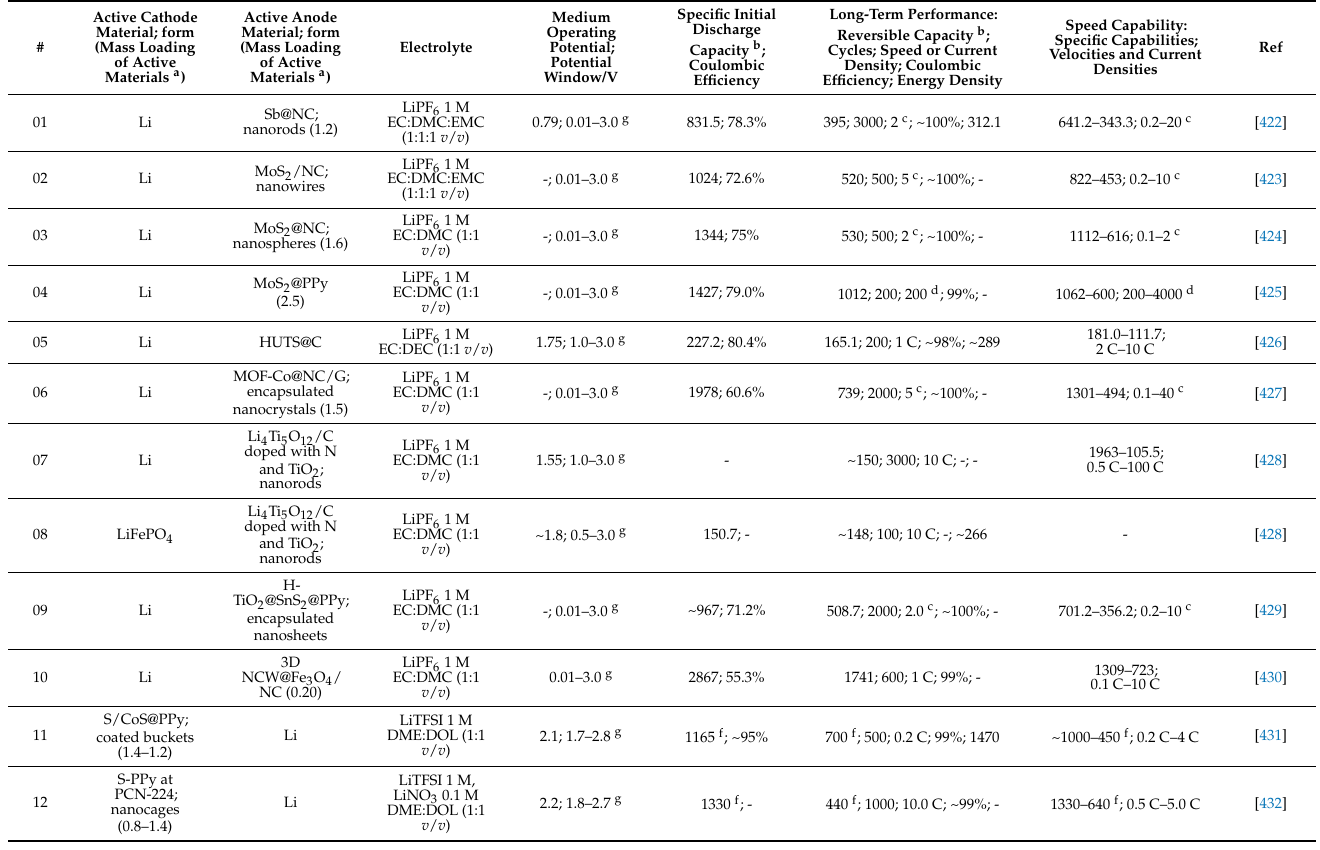
Table 7. PPy nanostructured in various configurations, evaluated for rechargeable battery electrodes, with their performance